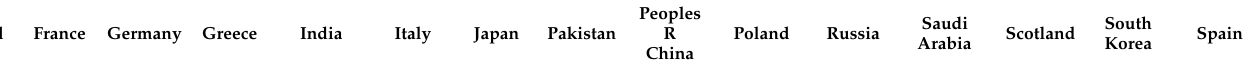
Table 4. WoS co-occurrence of the countries in the ontology- and fuzzy-based IS field.